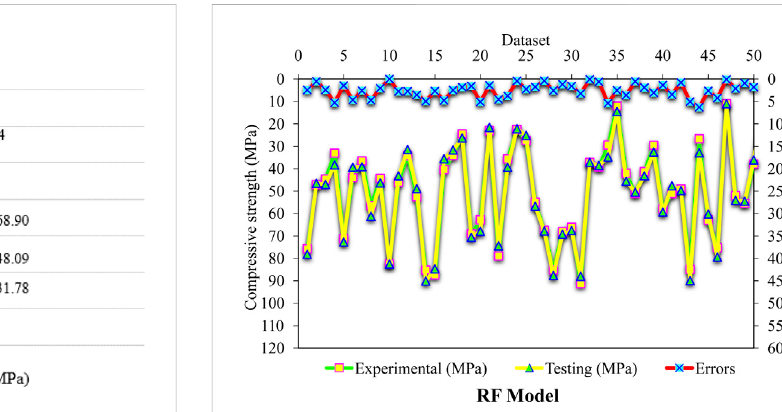
FIGURE 13 Box plot for Adaboost predicted and actual results.